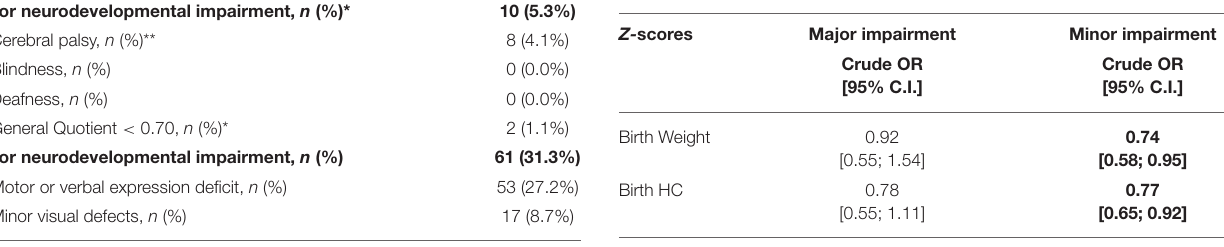
TABLE 5 | Evaluation of possible association between EUGR definitions and major and minor neurodevelopment impairment at 24 months of corrected age. Trait